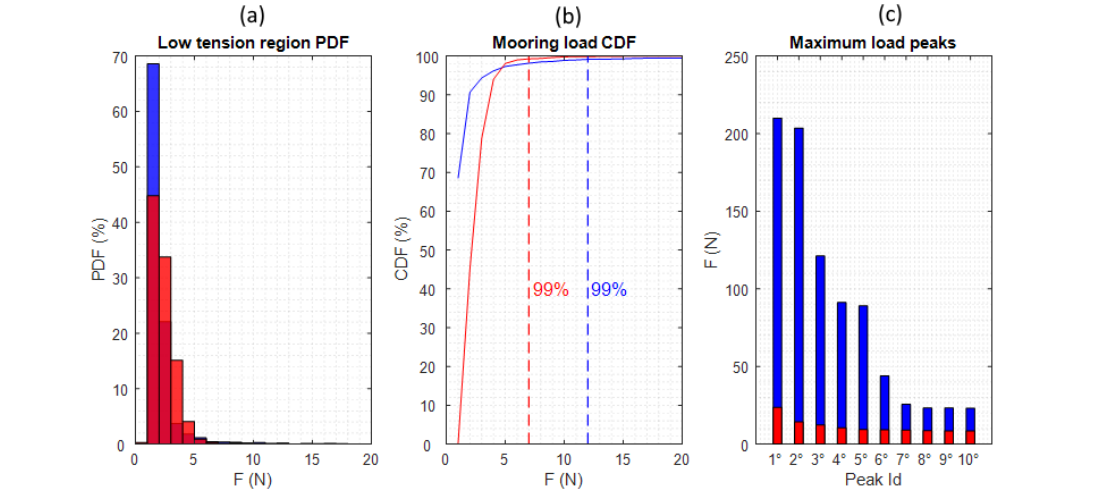
Figure 25. Mooring loads statistical distribution (PDF: probability density function; CDF: cumulative density function): 100-year wave, C1 (in blue: ) and C2a (in red: )